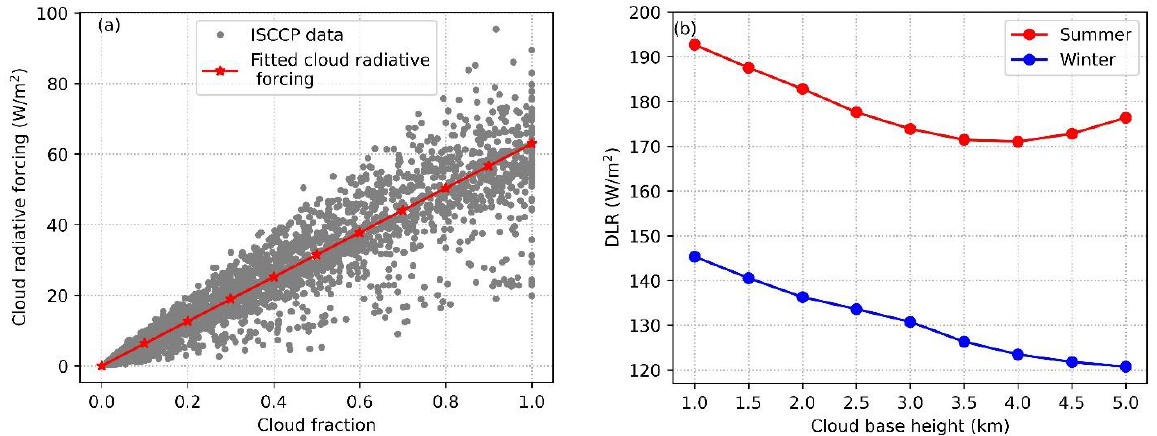
Figure 8. The influence of cloud fraction and cloud base height on DLR estimation. ( a ) displays the DLR variation (i.e., cloud radiative forcing) caused by variation of cloud fraction at SPO site. ( b ) Displays the DLR variation caused by variation of cloud base height for a summer atmospheric profile and a winter atmospheric profile at SPO.